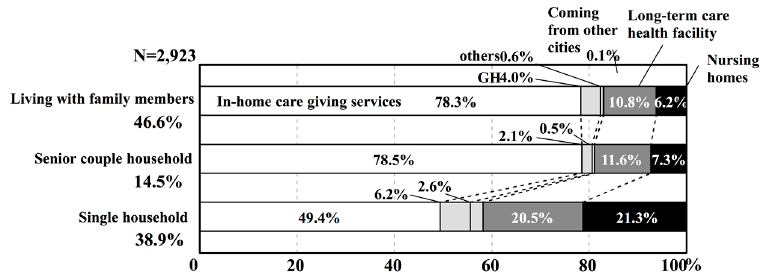
Figure 6. Proportion of services used according to type of household where the person is aged 65 years or older in K City.